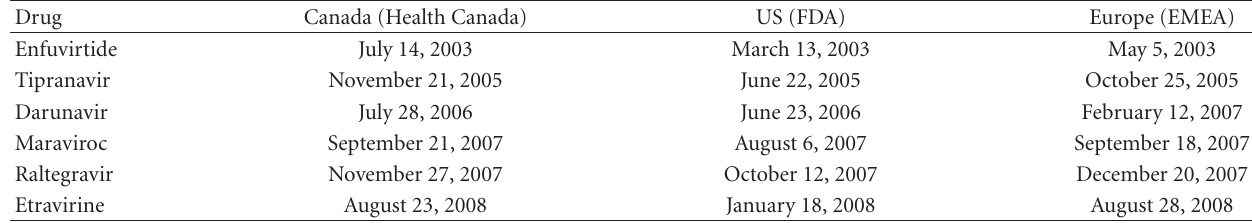
Table 2: HIV drug approval/authorization